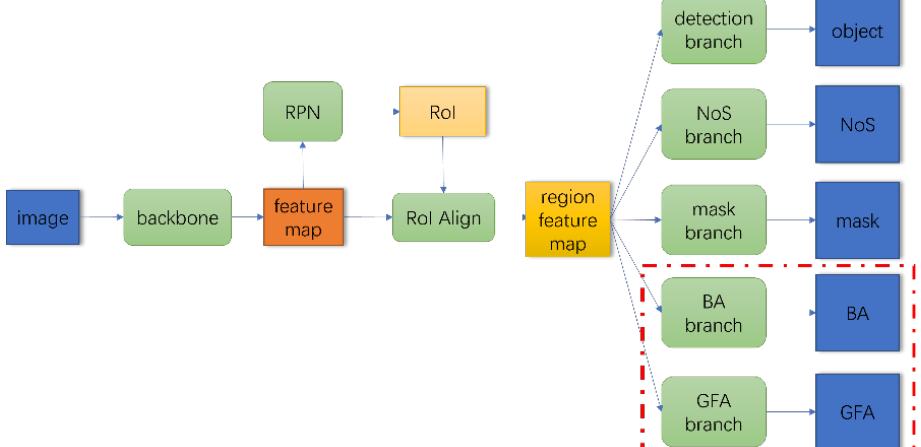
Figure 1. Main architecture of NoS R-CNN. This figure is from [3].